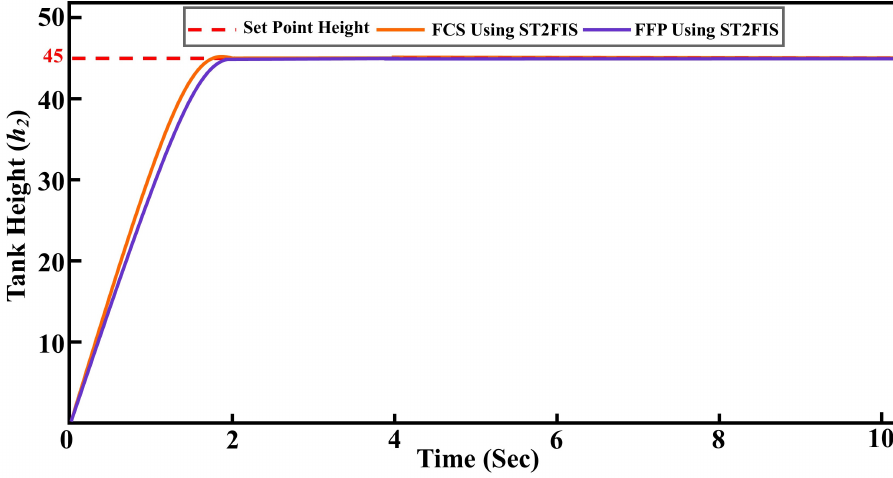
Figure 12. Comparative results of TTCFNLC process subject to without fault using fuzzy CS and FP